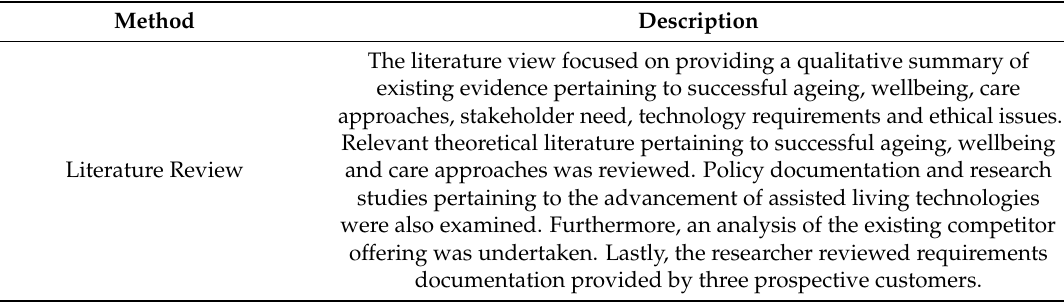
Table A2. Overview of study 1a